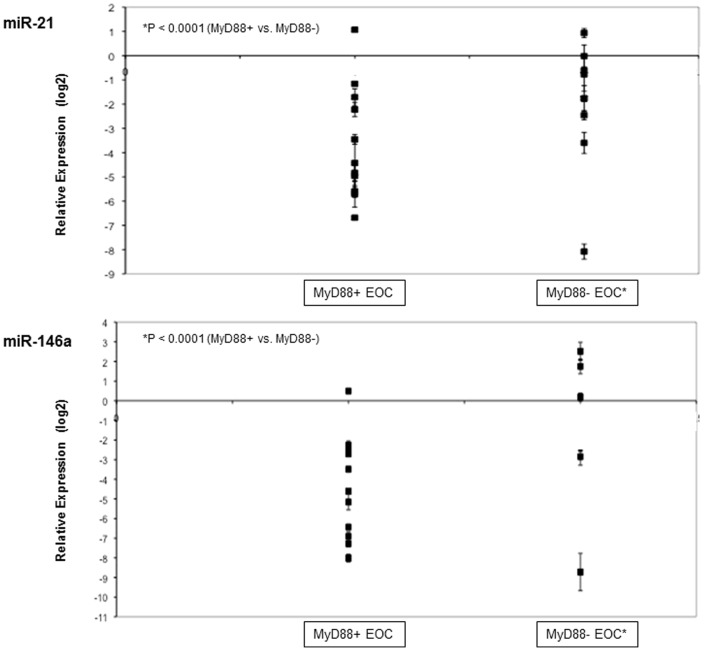
MiR-21 & miR-146a expression in the test series.Scatter plots showing relative microRNA expression with standard deviation (fold changes calculated via the 2−ΔΔCt method). 20 EOC cases (serous carcinomas) grouped as MyD88+ or MyD88- based on protein expression; data shown relative to each group. Average expression of miR-21 & miR-146a increased in MyD88 negative EOC (p<0.05).